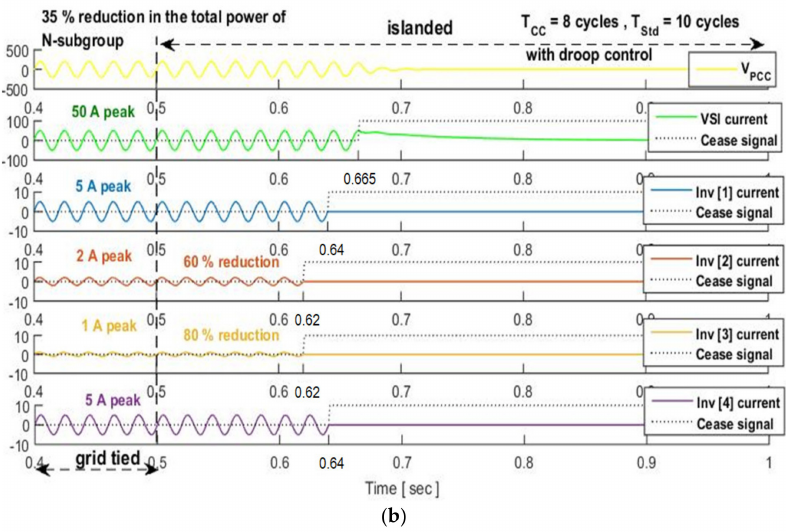
Figure 10. PCC voltage and inverter currents at reduced power levels (60% and 80% reduction for the inverters 2 and 3, respectively) and l = 4 ( T CC = 8 cycles), ( a ) without a droop-controller; ( b ) with a droop-controller.